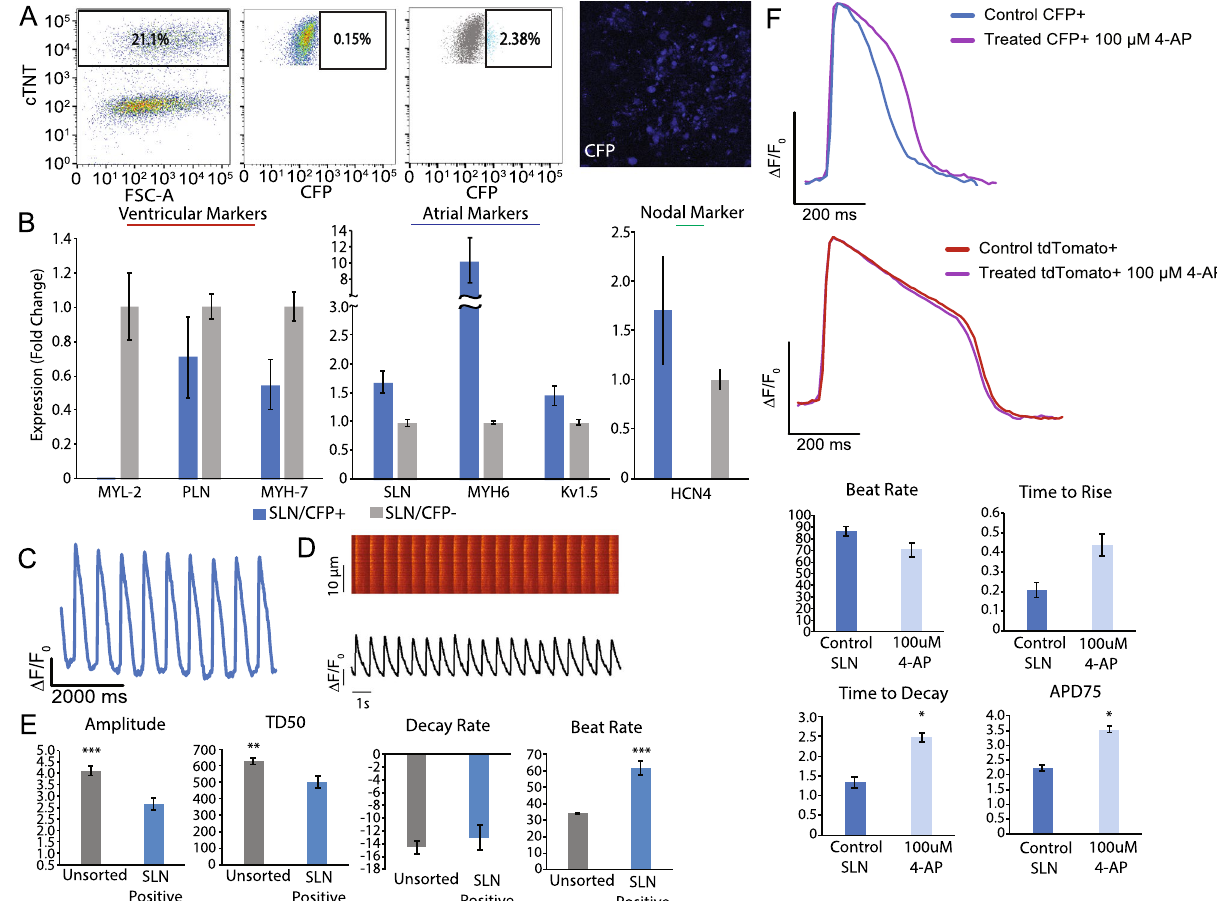
Figure 4. Characterization of the atrial human iPSC reporter line. ( A ) Representative FACS plots from day 30 cardiomyocytes, depicting the percentage of cells that are cTNT(+), control wild-type cells SLN/eCFP(–), and SLN/eCFP(+), within the cTNT(+) population after sorting. Representative image (right) of sorted SLN/ eCFP(+) cells 5 days after sort. ( B ) Real-time PCR of sorted cells SLN/eCFP(+) normalized to GAPDH (ΔCT) and SLN/eCFP(−) (ΔΔCT) population (n = 5). ( C ) Representative action potential tracing of SLN/eCFP(+) cells (day 30) using voltage activated fluorescent dye (n = 8). ( D ) Representative calcium tracing and